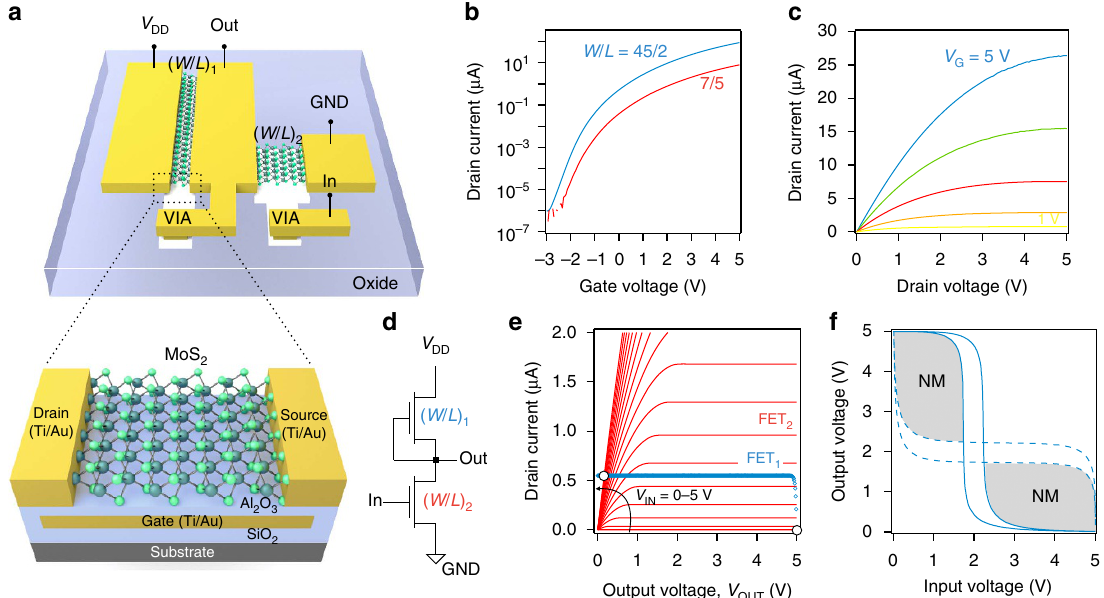
Figure 2 | Characterization of MoS 2 transistors and inverter. ( a ) Schematic drawing of an inverter circuit (top) and an individual MoS 2 transistor (bottom) in gate-first technology (see Supplementary Fig. 5 for corresponding micrograph). ( b ) Transfer characteristics of load ( W / L ¼ 45/2) and pull-down ( W / L ¼ 7/5) transistors. ( c ) Output characteristic for gate voltages between 1 and 5V (in 1V steps). ( d ) NMOS inverter circuit schematic. ( e ) Graphical construction to determine the output voltage V OUT of an inverter for a given input voltage V IN . The blue symbols show the load curve and the red lines are the output characteristics of the pull-down transistor (in 0.25Vsteps). The intersection point of both curves determines V OUT . ( f ) The solid line shows the measured voltage transfer characteristic of an inverter. By mirroring this curve (dashed line) a butterfly plot is obtained, from which NM can be extracted by nesting the largest possible square in the grey shaded area.